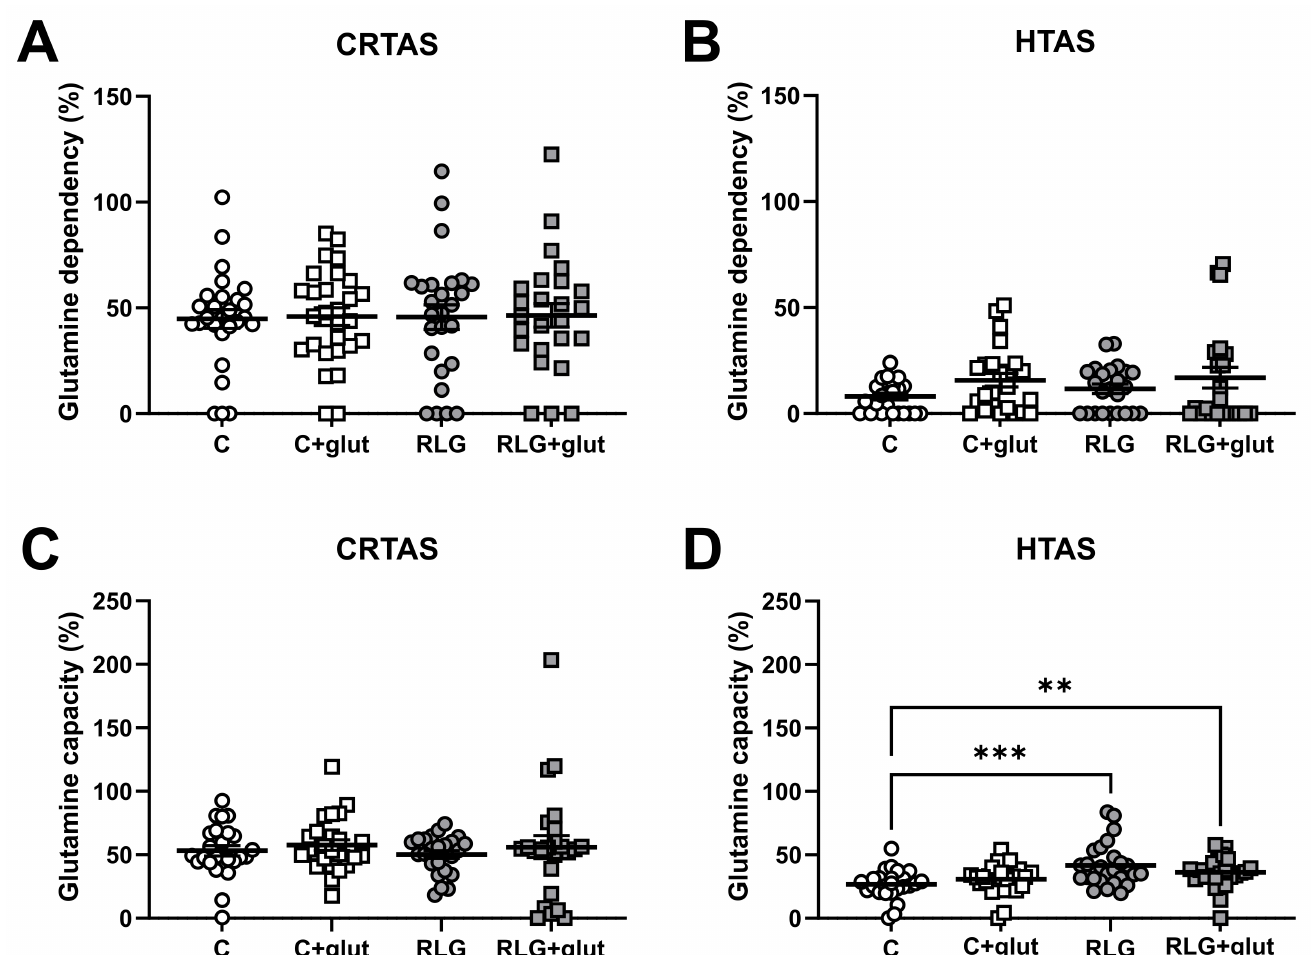
Figure 6. RLG and RLG plus glutamate altered mitochondrial fuel flexibility to increase the capacity to metabolise glutamine. Using pyruvate, fatty acid, and glutamine fuel pathway inhibitors, UK5099, etomoxir and BPTES (bis-2-(5-phenylacetamido-1,3,4-thiadiazol-2yl)ethyl sulfide), respectively, al- lowed for the measurement of the percentage of which CRTAS and HTAS were dependent on or had the capacity to metabolise glutamine. Dependency: contribution of that pathway to basal OCR. Capacity: maximal ability to consume oxygen through the pathway. CRTAS (( A ); n = 25–28) and HTAS (( B ); n = 24–25) dependency on glutamine fuel pathway. CRTAS (( C ); n = 24–25) and HTAS (( D ); n = 25–26) capacity to metabolism glutamine fuel pathway. Error bars represent standard error of the mean. ** p < 0.01; *** p < 0.001. Normally distributed data were analysed using one-way ANOVAs with post hoc Tukey’s multiple comparisons test. Abnormally distributed data were anal- ysed using Kruskal–Wallis test with post hoc Dunn’s multiple comparisons test.3.9. Extracellular glutamate clearance is increased in HTAS following RLG and sustains ATP levels after